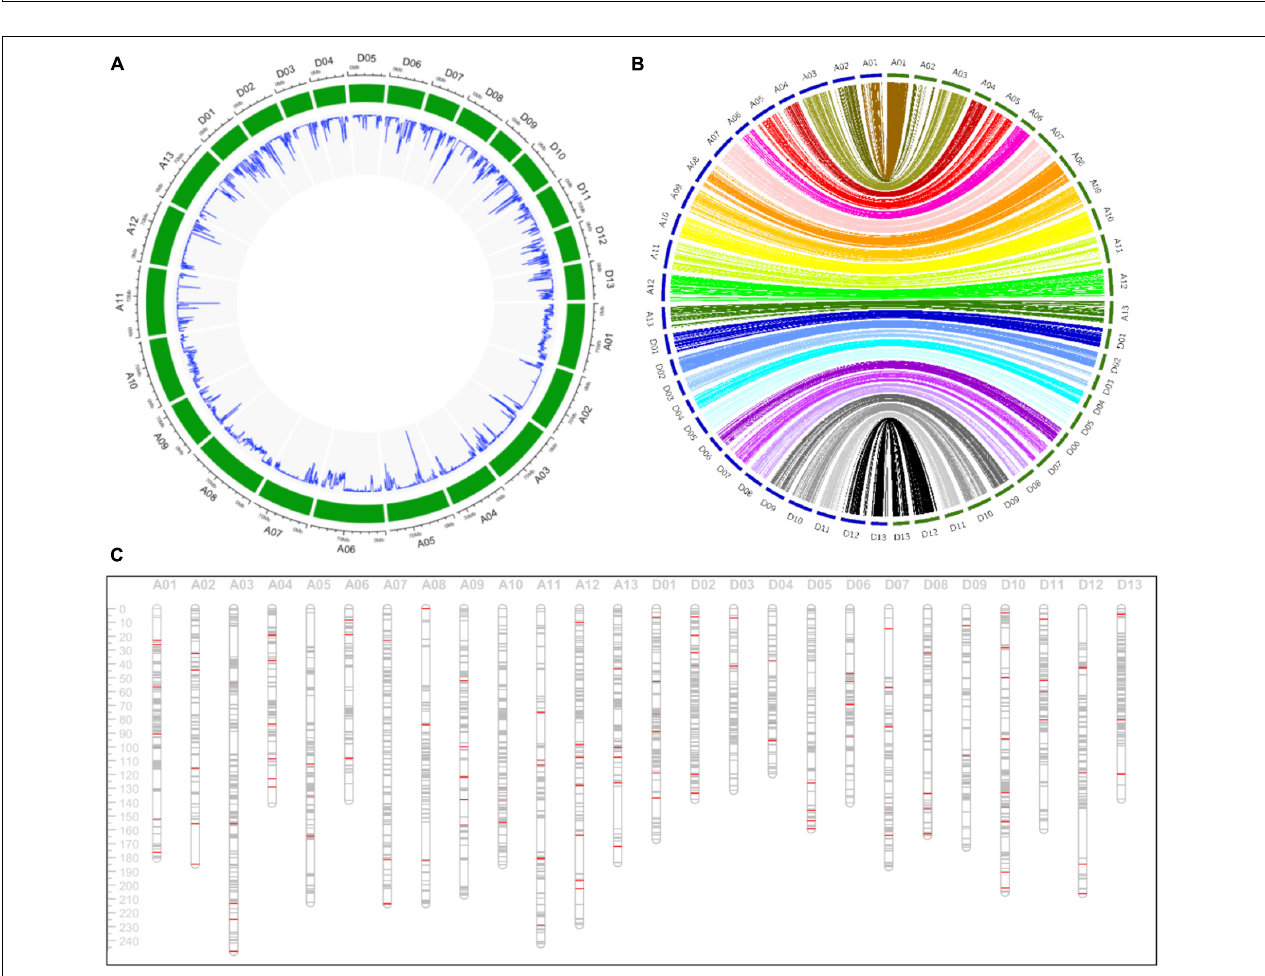
FIGURE 2 | Detailed information about the genetic linkage map. (A) The density of SNP markers in the G. hirsutum genome in a 500 Kb window. (B) The collinearity analysis of markers between the genetic map and the physical map. The blue circle and the green circle indicating the genetic map and the physical map, respectively. (C) The distribution of markers in the genetic map. The gray lines and the red lines indicating SNP and SSR markers, respectively.